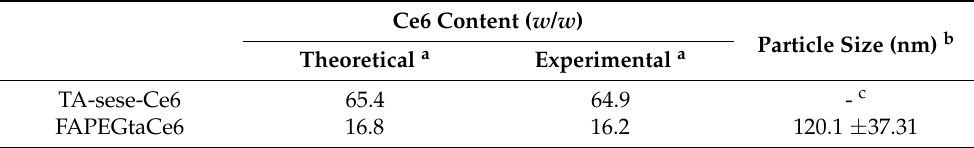
Table 1. Characterization of FAPEGtaCe6 nanophotosensitizers.